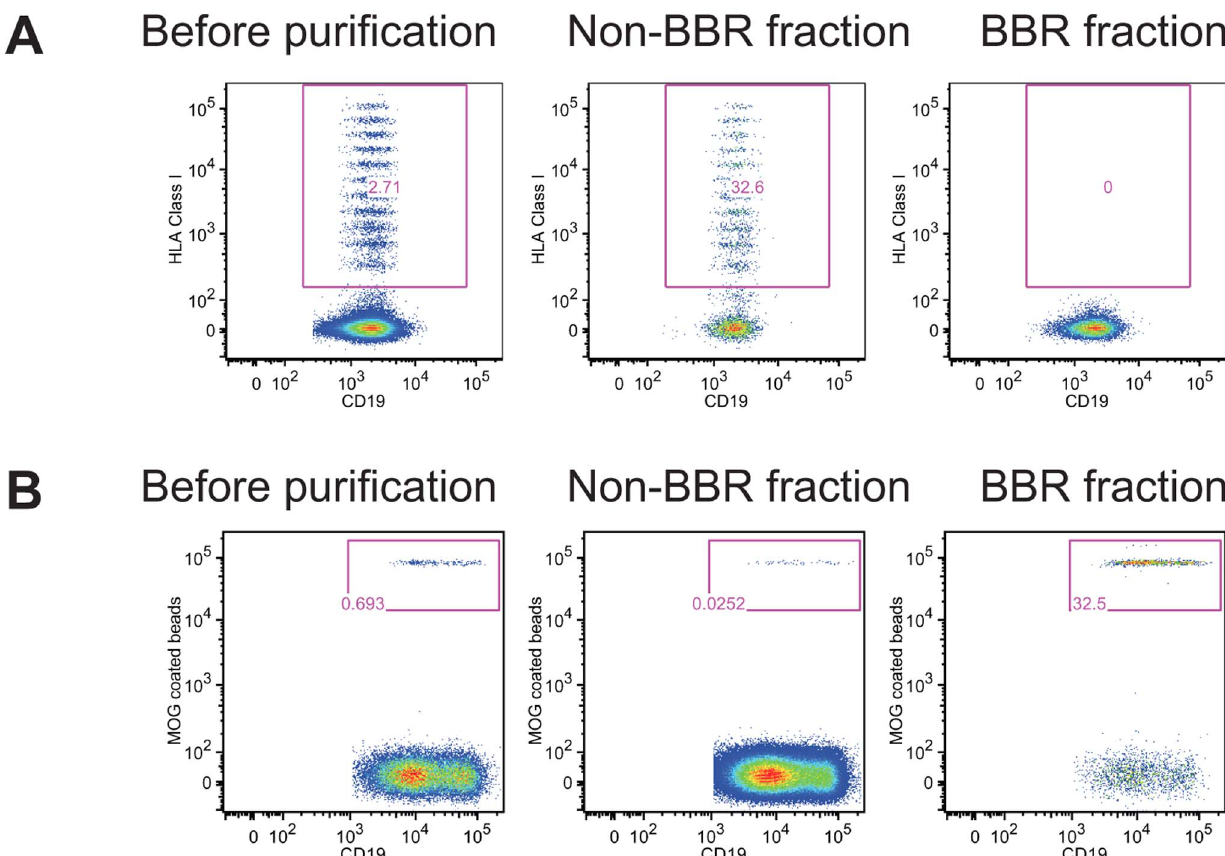
Figure 4. Separation of B cells interacting with nominal antigen and unbound B cells. Purified B cells were incubated with single HLA class I coated beads (A) or MOG 1–125 coated beads (B) before being subjected to cell separation using an ARIA FACS-sorter (A) or magnet based purification (B). Frequency of B cells interacting with nominal antigens is shown before purification and in the positive and in the negative fraction. One representative out of three experiments with cells from different donors is shown.